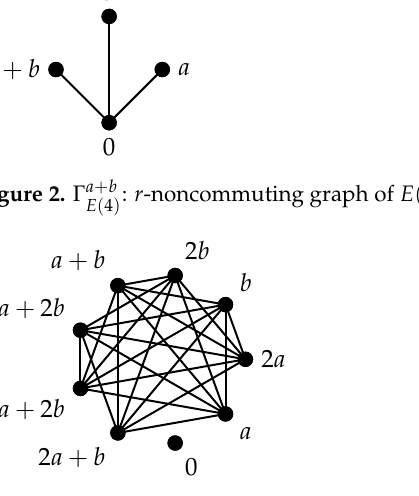
Figure 1. Γ 0 : r -noncommuting graph of E ( 4 ) when r = 0. E ( 4 )